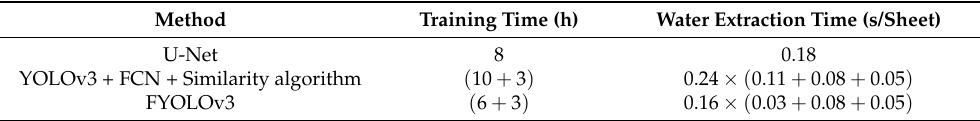
Table 5. Comparison of the model training time and water extraction